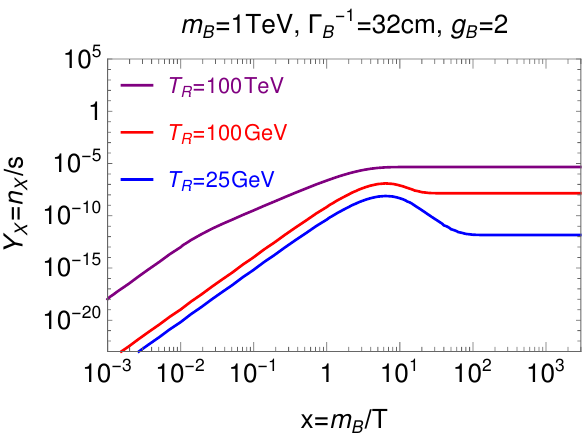
Figure 5. Freeze-in comoving number density from B decays for a Weyl fermion ( g B = 2 ) during an early MD era. We fix m = 1 TeV and Γ − 1 = 32 cm, and we consider three different values B B → A SM X for the reheating temperature. Relic density requires: m = 100 keV (purple line), m X (red line), m = 300 GeV (blue X